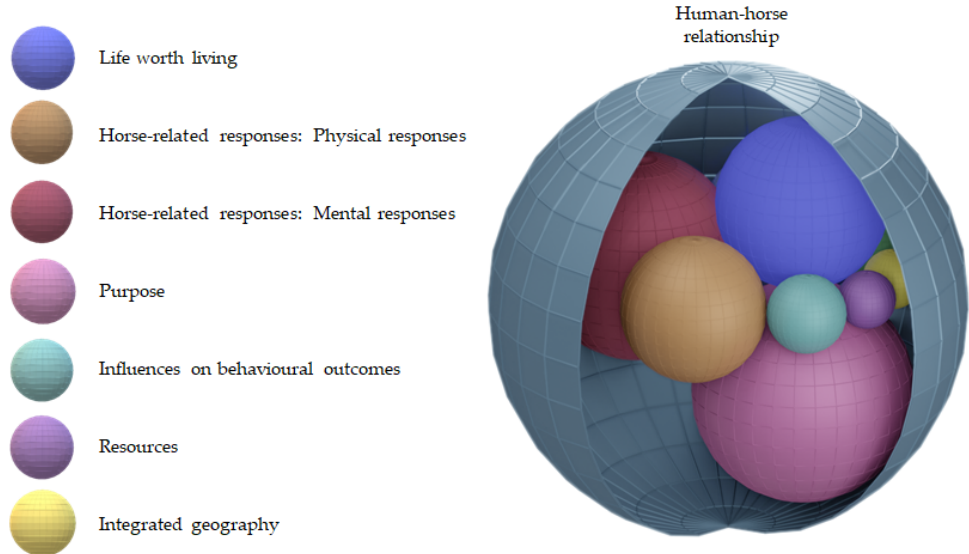
Figure 1. Image of the conceptual model using a theoretical human–horse relationship to represent themes and their interaction at a cross-section in time. The sphere size does not represent quantification as the relative importance of each theme is unique for a particular human and horse at a particular point in time.